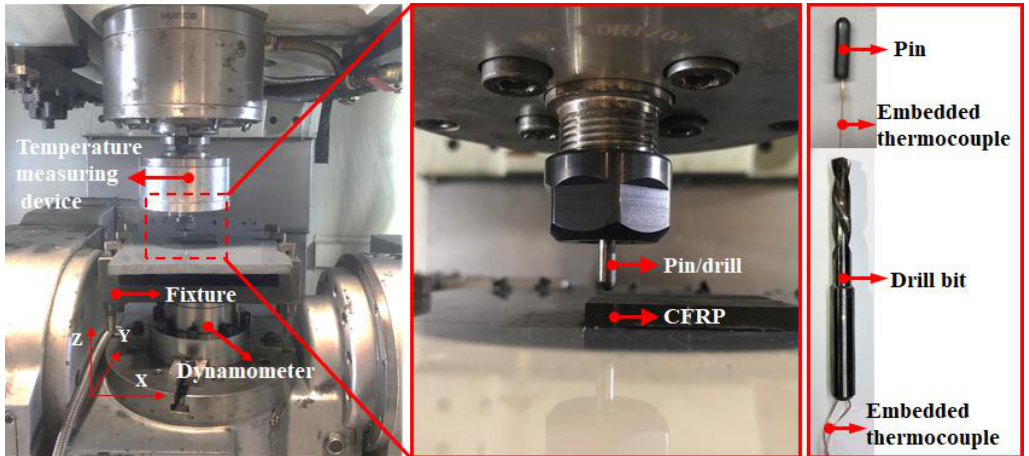
Figure 2. The experimental setup for the pin-on-disc tests and the used pin/twist drill.